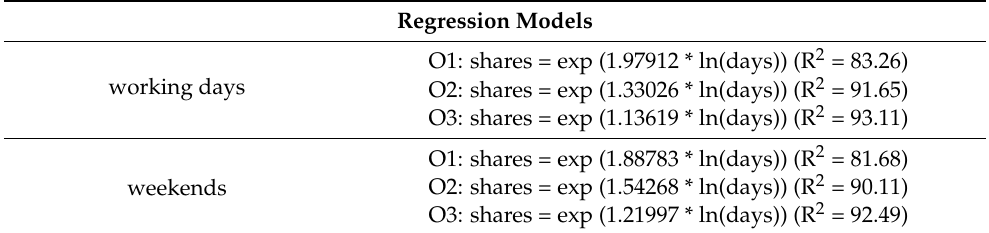
Table 5. Linear regression model for shares during working days and weekends in each observation.